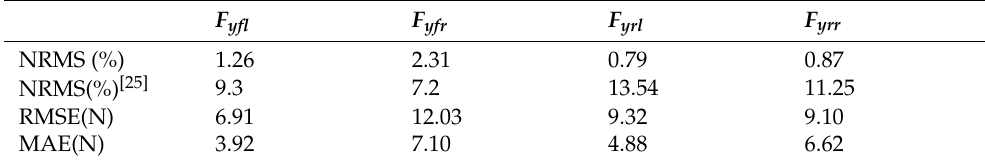
Table 6. The lateral force estimation error.